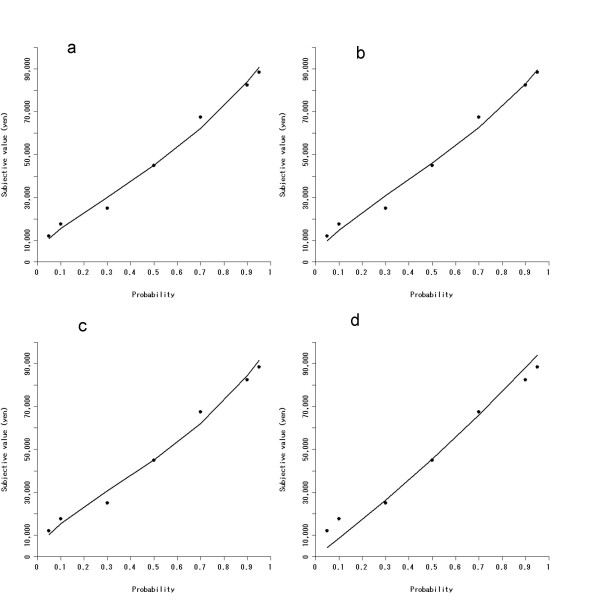
Group median data of probabilistic choice (dots) are presented with lines of prediction from the four types of probabilistic choice models: (a) entropy model, (b) Prelec's weight function, (c) general hyperbolic function, (d) simple hyperbolic function. Horizontal axis indicates probability values (0–1), while vertical axis indicates a subjective value (0–100,000 yen) of the uncertain reward at each value of probability. It can be seen that the simple hyperbolic function poorly fit the data at small and large probability values.